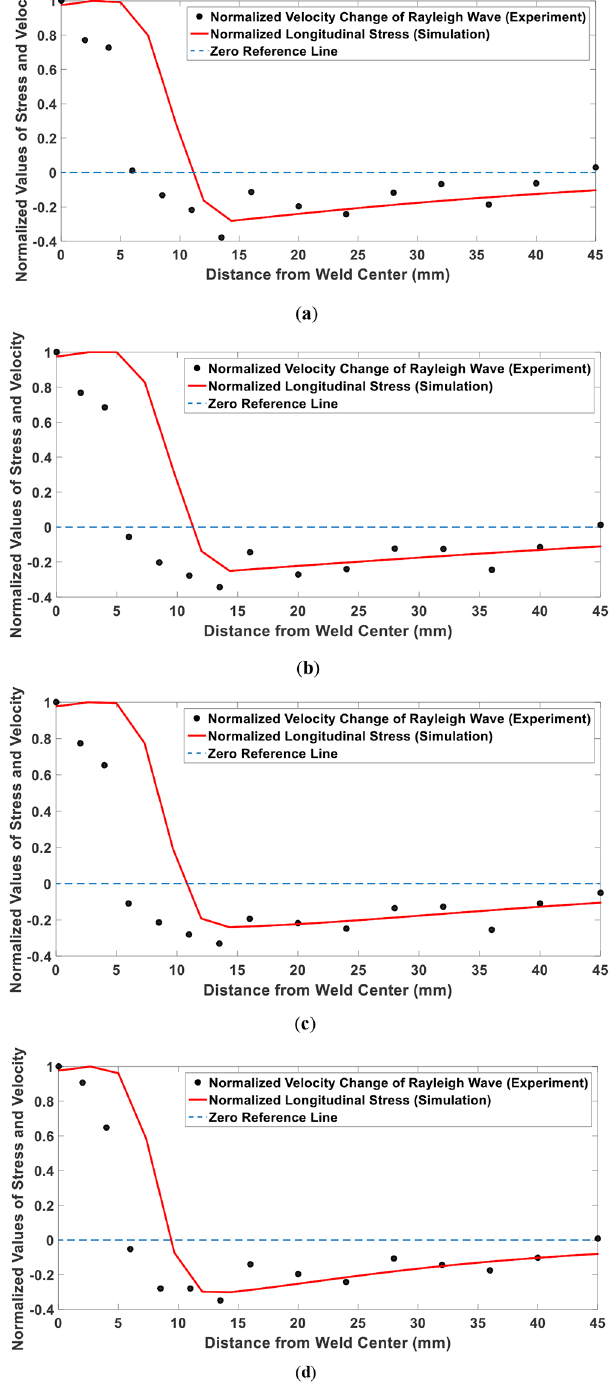
Fig. 15. Comparison of normalized relative velocity variations from ToF experiments and normalized longitudinal residual stress from FEA simulation for (a) row #1 tests, (b) row #2 tests, (c) row #3 tests, and (d) row #4